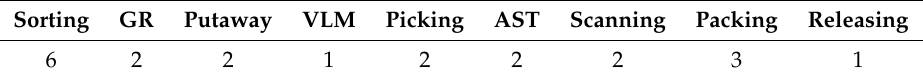
Figure 7. Numerical results for July 2018 data, given the total numbers of inbound/outbound pallets of 1656/1529, and the numbers of completed pallets with the current worker allocation are 1231/621. Table 3. The current assignment used in the